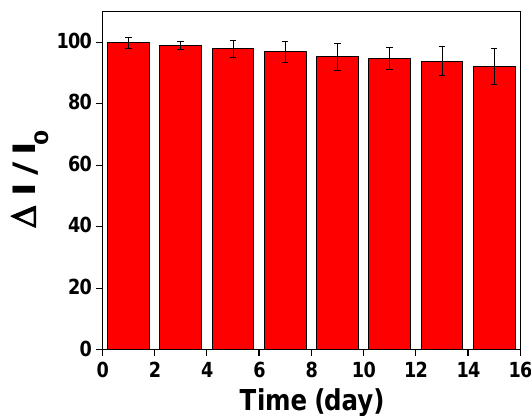
Figure 8. Storage stability of the AuNP – GO – anti-IgG probe onto sensing chip.